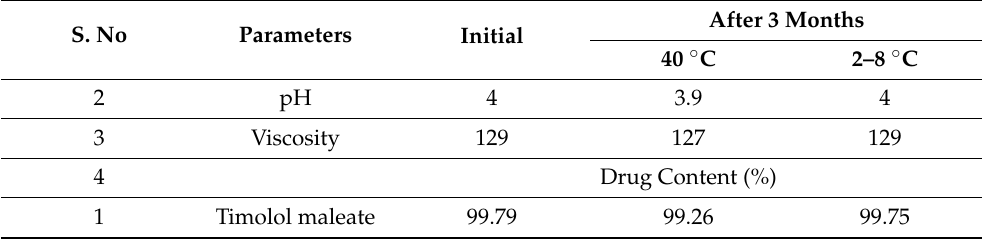
Table 7. Stability studies of optimized Timolol maleate nanoemulsion in situ gel.